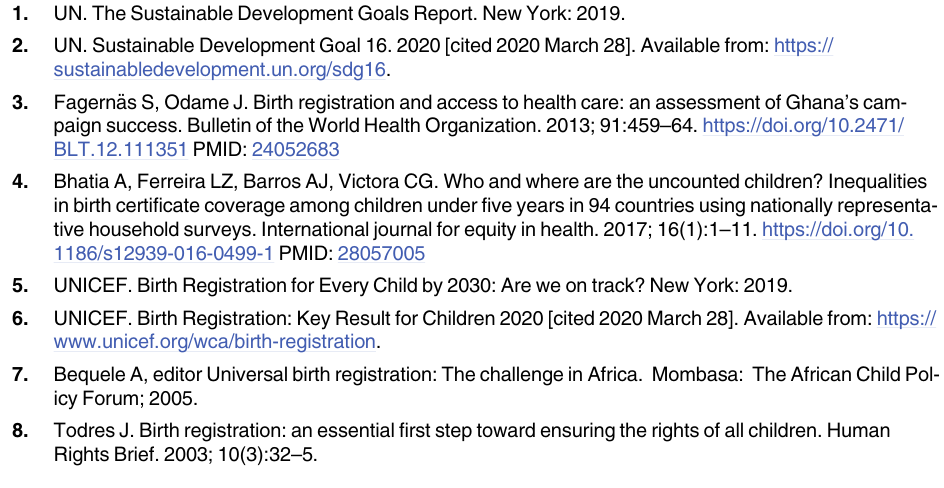
S3 Table. Descriptive statistics of context factors. S4 Table. Full results of multilevel logistic